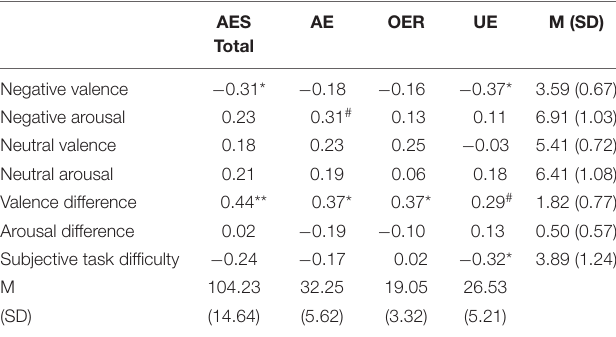
TABLE 1 | Means (M), standard deviations (SD) and correlations between self-report EI (AES Total score and subscales) and task-specific variables ( N = 40).